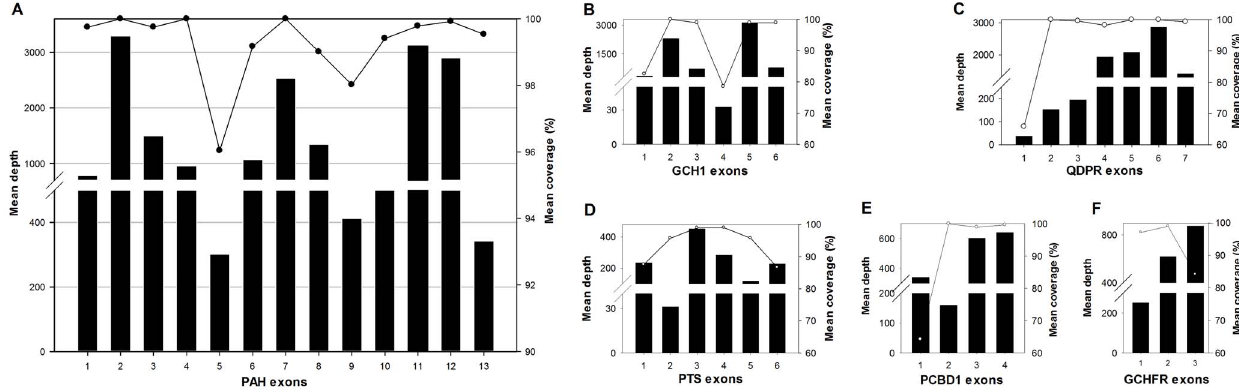
Figure 3. Mean depth of coverage and percentage of coverage of each exon of the six genes from all reads sequenced using a PGM. (A), (B), (C), (D), (E) and (F) indicate data from the PAH,GCH1,QDPR,PTS,PCBD1 and GCHFR genes, respectively. The black columns indicate the mean depth of coverage, and the black circles indicate the mean percentage of coverage in each exon.